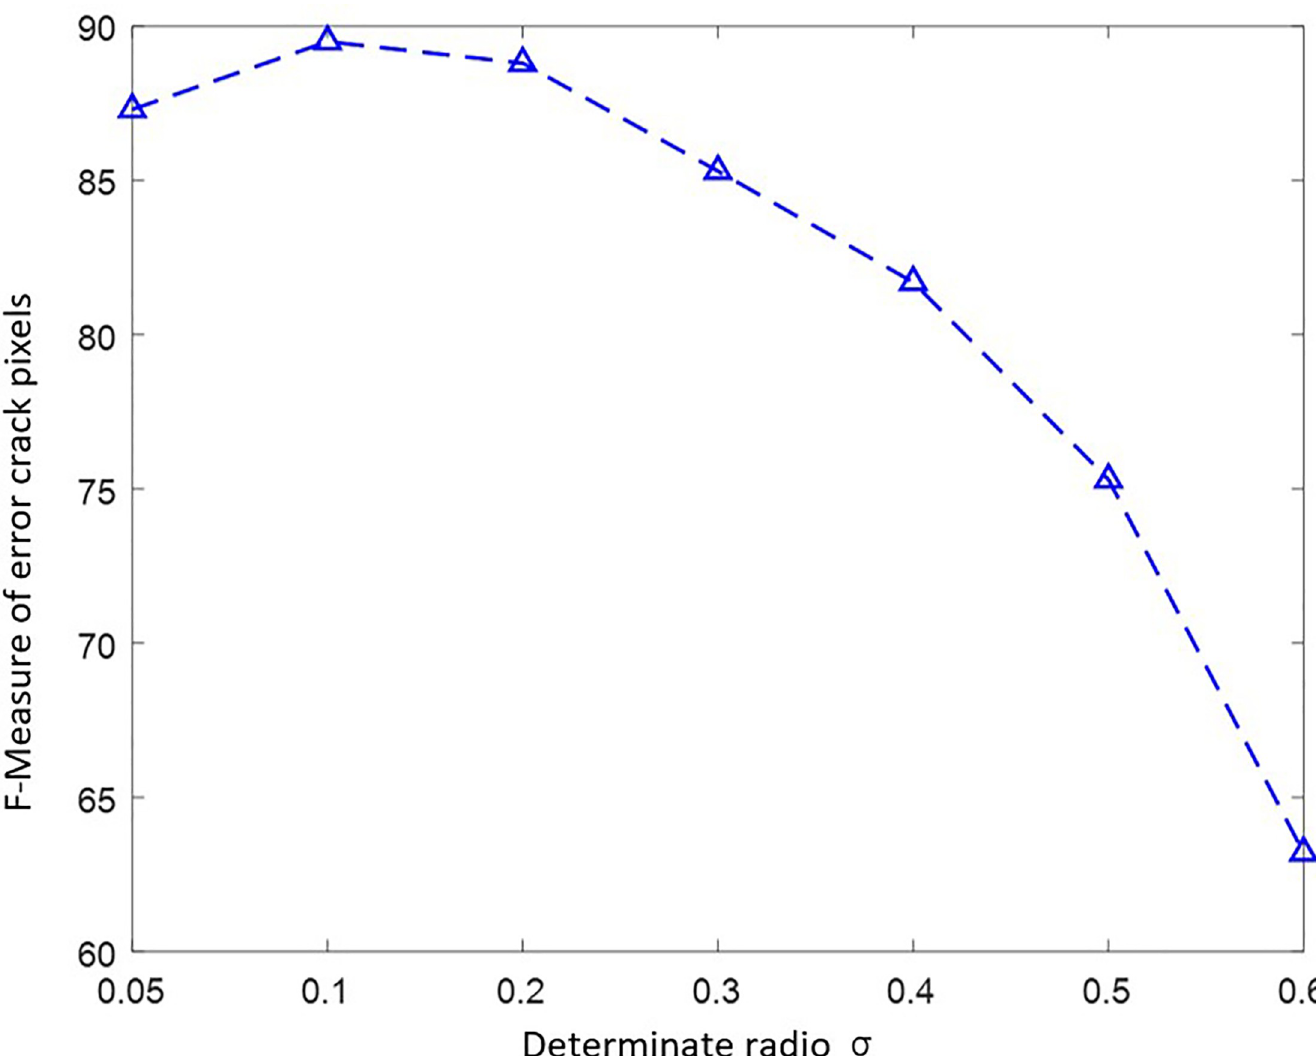
Fig 10. F-Measure of error crack pixels for different determinate